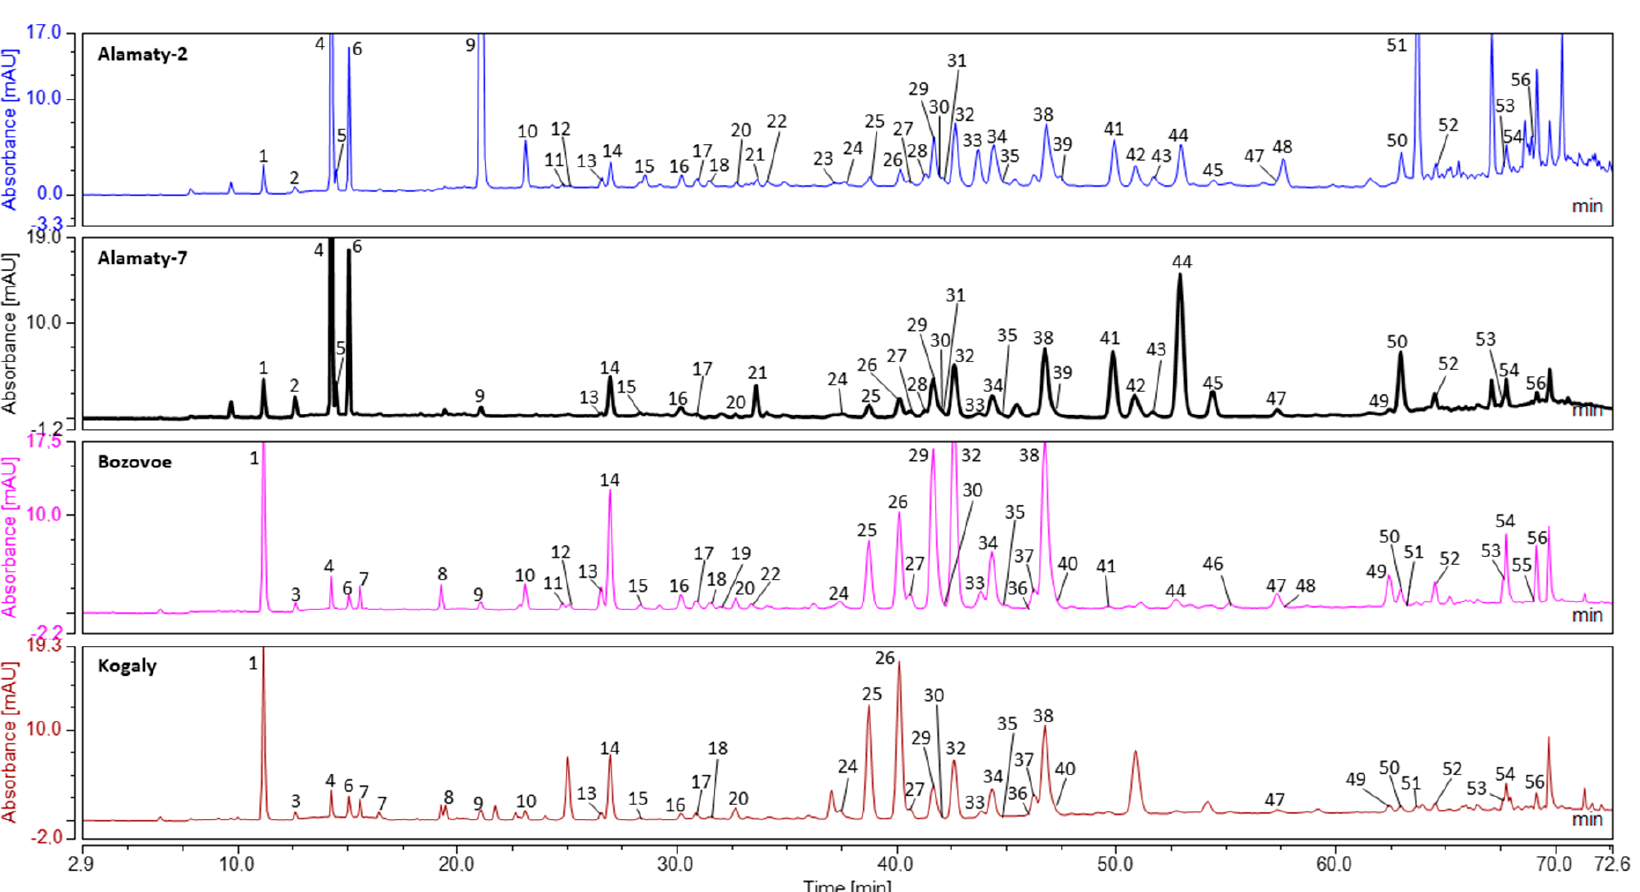
Figure 1. Representative uHPLC-DAD chromatograms of Kazakhstan propolis. Figure Legend: 1—Caffeic acid; 2—Vanilline; 3—Caffeoylglycerol; 4— p -Coumaric acid; 5—Benzoic acid; 6—Ferulic acid; 7—Isoferulic acid; 8—Caffeoylmalic acid (Phaseolic acid) isomer; 9—Cinnamic acid; 10—Pinobanksin-5-methyl ether; 11—Quercetin; 12—luteloin; 13—Quercetin-3-methyl-ether; 14—Pinobanksin; 15—Naringenin; 16—Apigenin; 17—Kaempferol; 18—Isorhamnetin; 19—Quercetin- methyl-ether; 20—Luteolin-5-methyl-ether; 21—1,3-di- p -Coumaroylglycerol; 22—Quercetin-dimethyl-ether; 23—2-Acetyl-1,3-di-caffeoylglycerol;